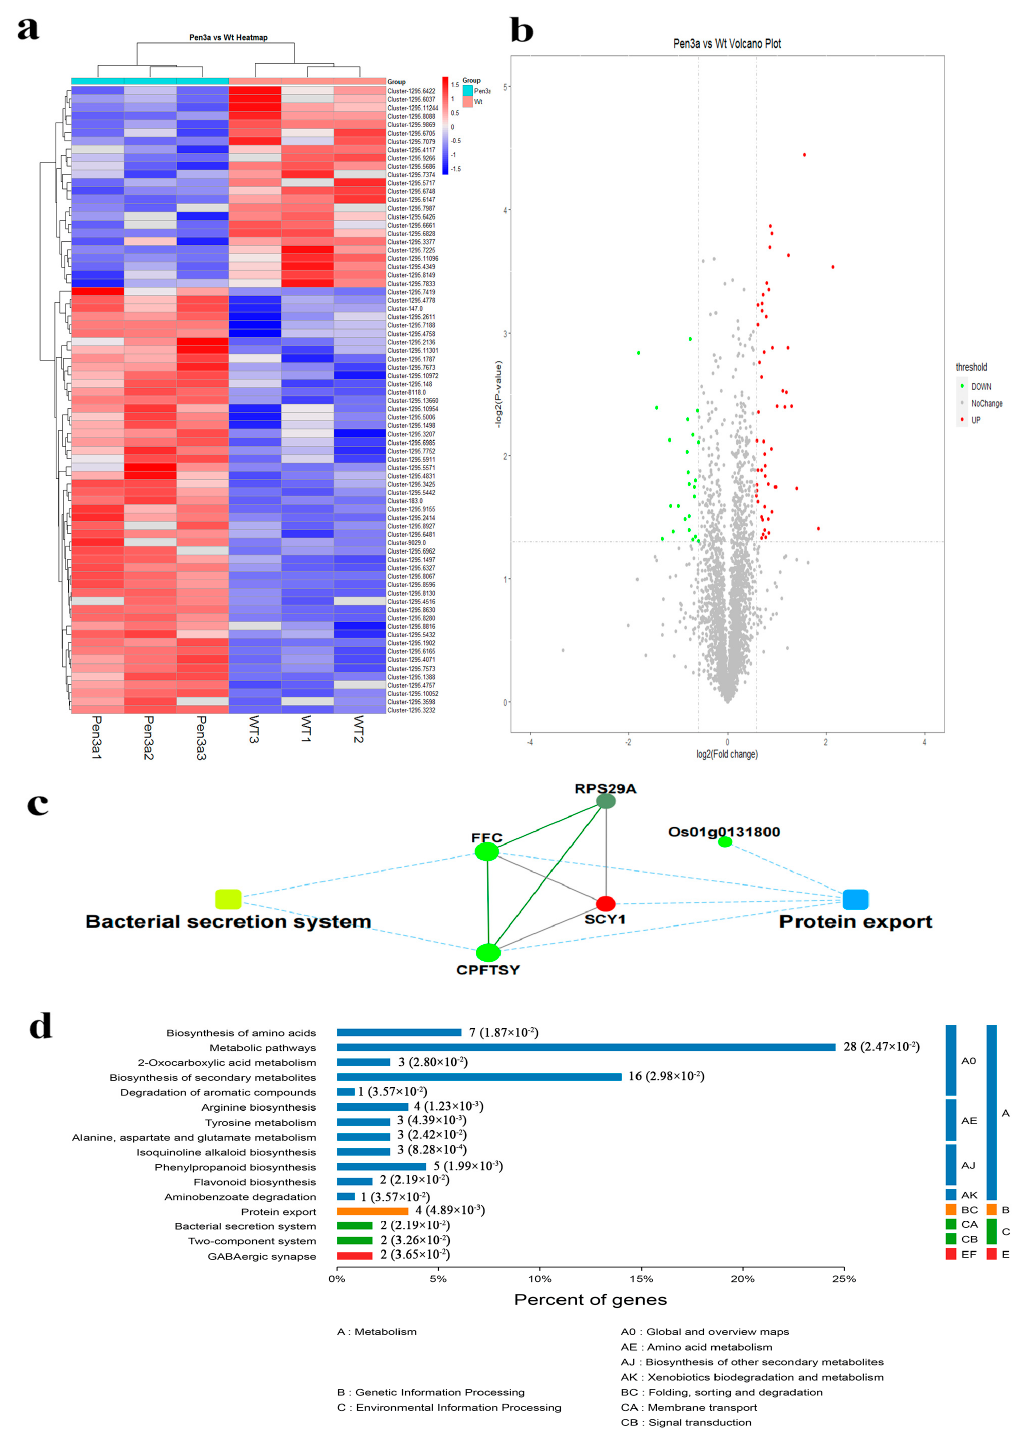
Figure 9. Proteomic analysis. ( a ) Results of hierarchical cluster analysis of expressed proteins to Pen3a and WT comparison group. The protein abundance was shown as color code, blue means lower abundance and red means higher abundance. Abundance difference factor in protein hierarchy clustering p < 0.05. ( b ) Volcano Plot between Pen3a and WT comparable group. The red dots were significantly up-regulated proteins, the green dots were significantly down-regulated proteins, and the gray dots were non-significantly different proteins. ( c ) Interaction network results of differentially expressed proteins in Pen3a vs. WT comparison group. ( d ) KEGG enrichment pathway statistics of Pen3a vs. WT comparison group.